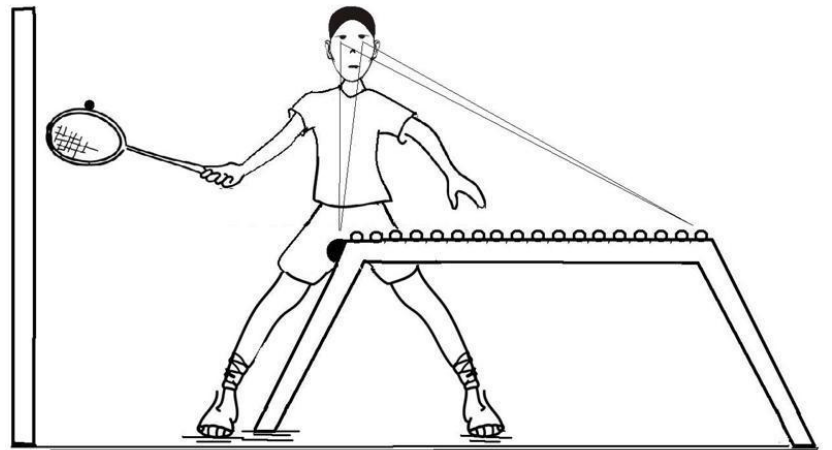
Figura 1. Representação da Situação de Foco no Contato, Mostrando a Ação Interceptativa e o Trilho Eletrônico para Respostas